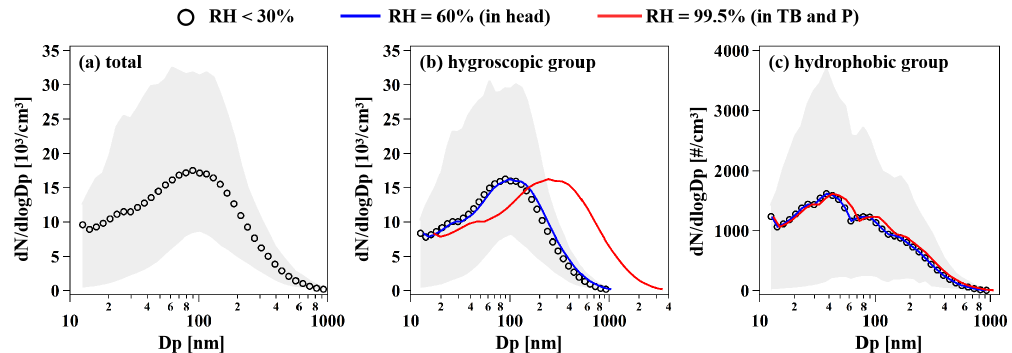
Figure 1. (a) The average particle number size distribution (PNSD) measured by TDMPS during the sampling period. The average PNSDs of (b) hygroscopic and (c) hydrophobic groups in the human respiratory tract at different relative humidities (RHs). The black markers, blue lines, and red lines represent PNSDs under dry conditions (RH < 30%), in the head (RH = 60%), and in the TB and P (RH = 99.5%), respectively. The upper and lower edges of the gray area represent the 90th and 10th quantiles of PNSDs, respectively.